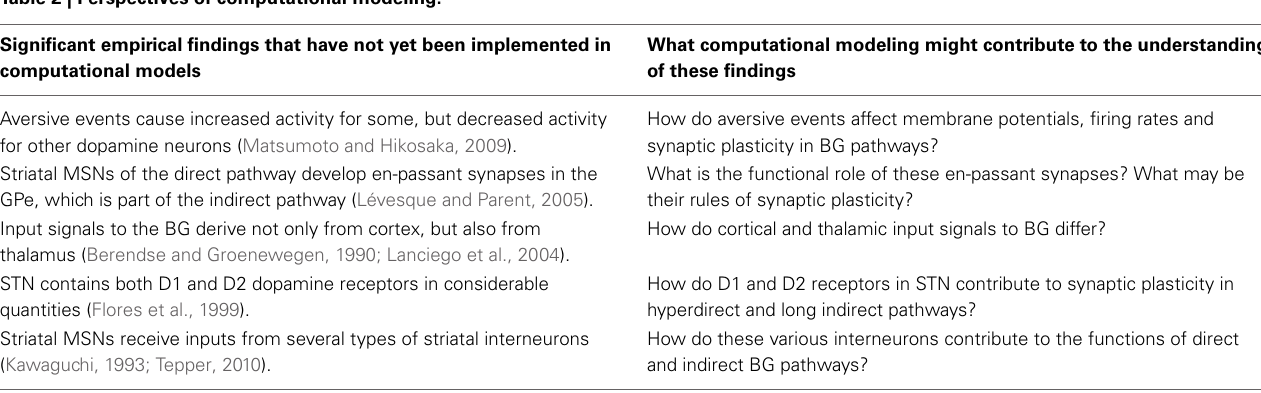
Table 2 | Perspectives of computational